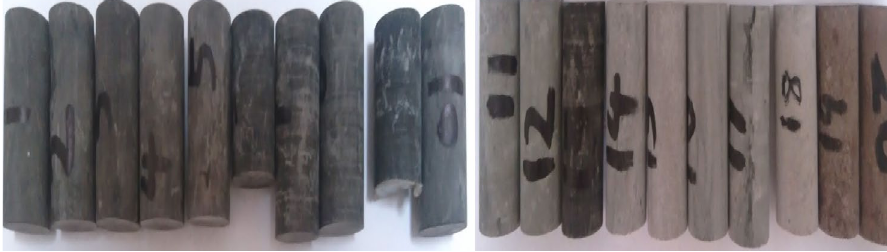
Fig. 3 Photographs of core samples used in triaxial rock mechanics